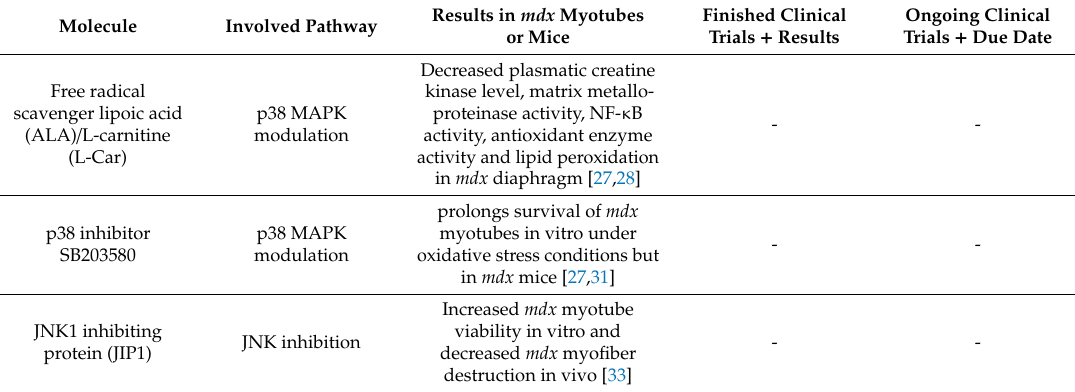
Table 2. Overview of p38 mitogen-activated protein kinases (p38 MAPK) and c-Jun N-terminal kinase (JNK) stabilizing molecules: results in mdx myotubes (in vitro) or mice (in vivo), finished clinical trials and results, ongoing clinical trials and due dates, and putative molecules. Results in mdx Myotubes Molecule Involved Pathway or